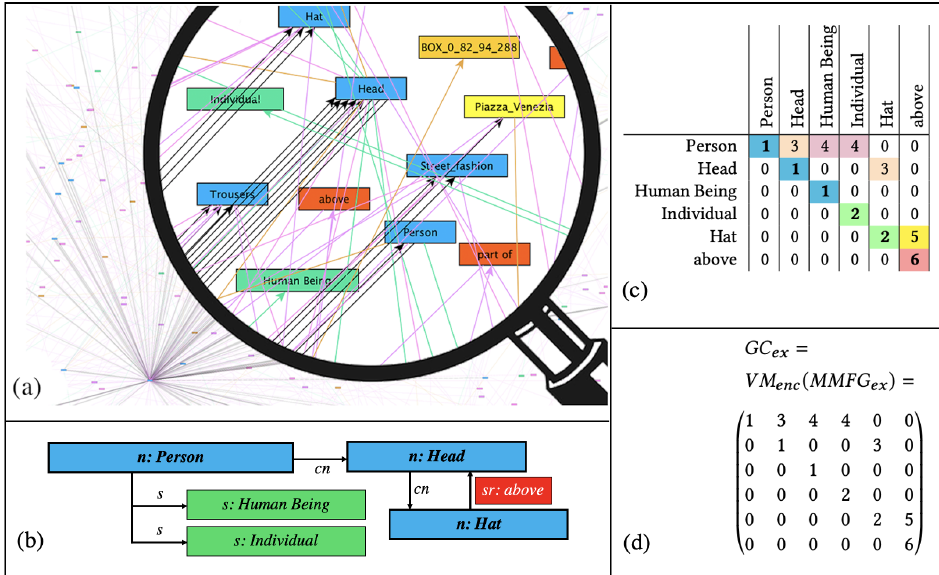
Figure 1. Exemplary MMFG and its related